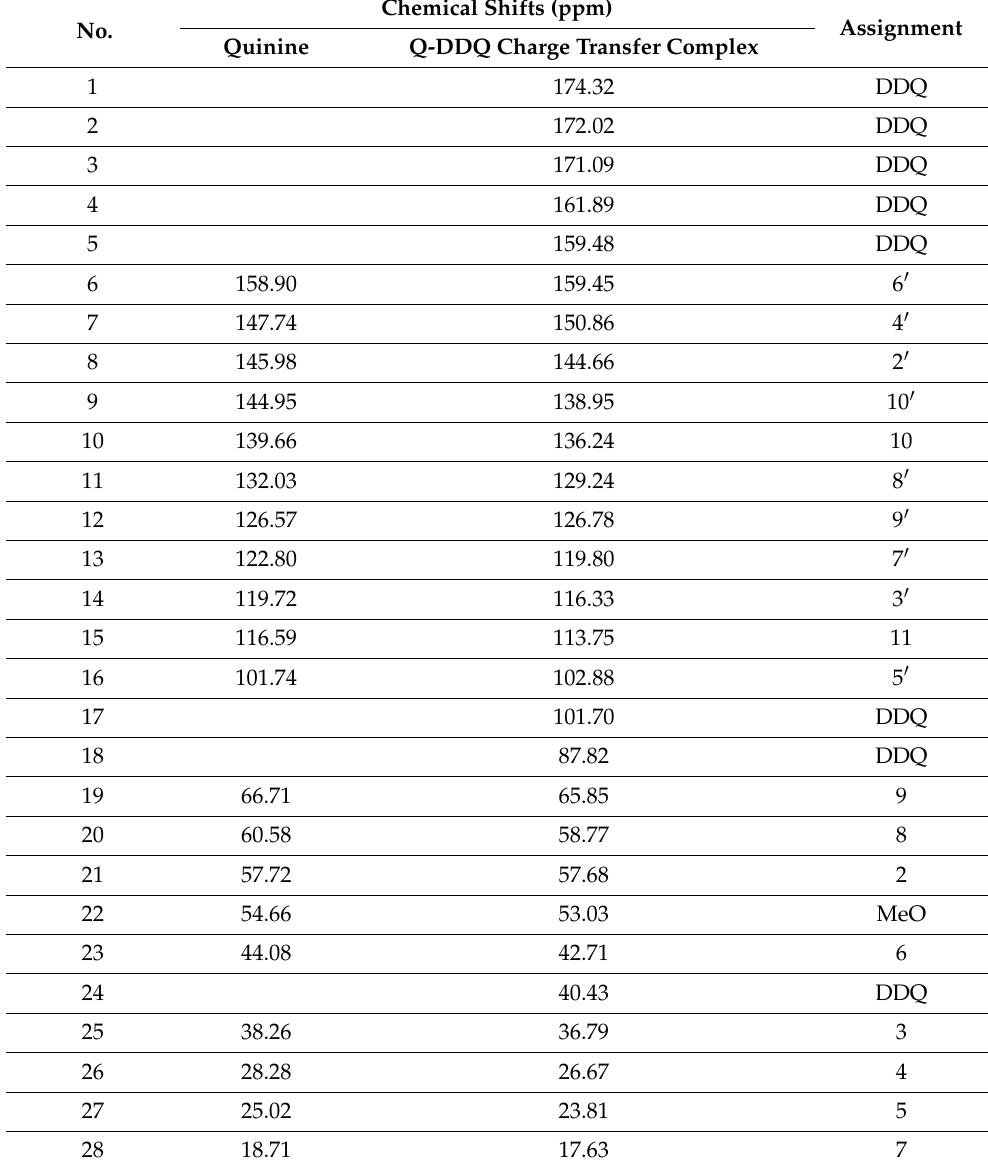
Table 4. 13 C NMR chemical shifts in ppm for quinine and quinine-DDQ charge transfer complex.